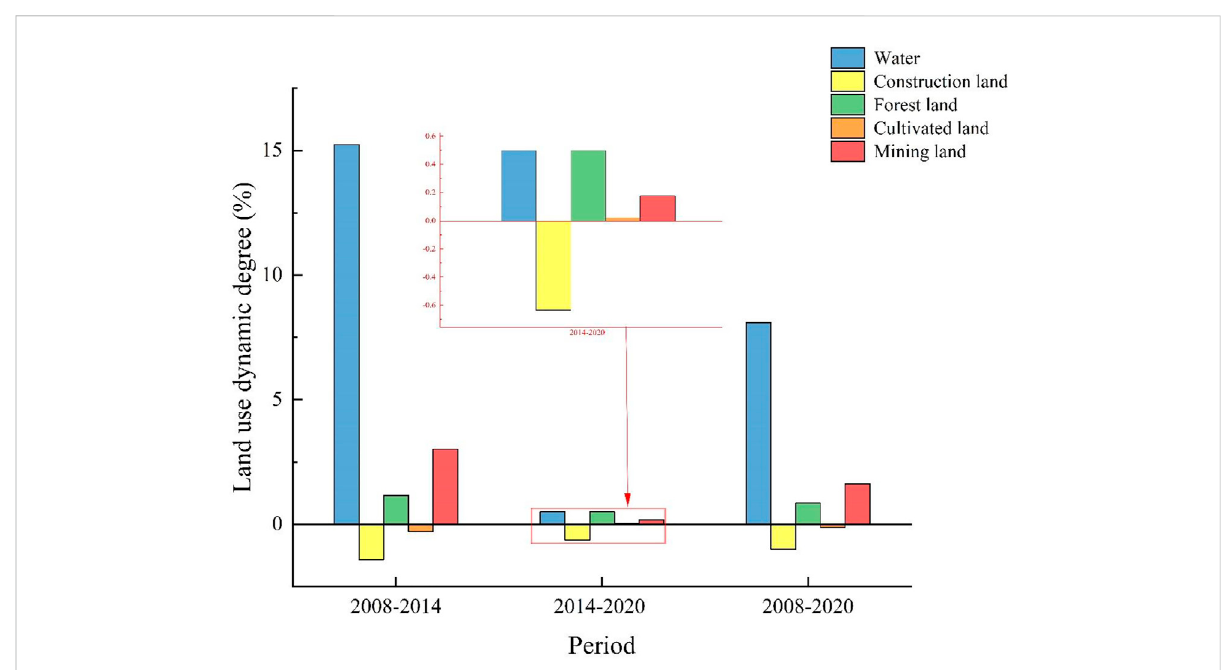
FIGURE 4 Dynamic degree of land use in Anshan urban area from 2008 to